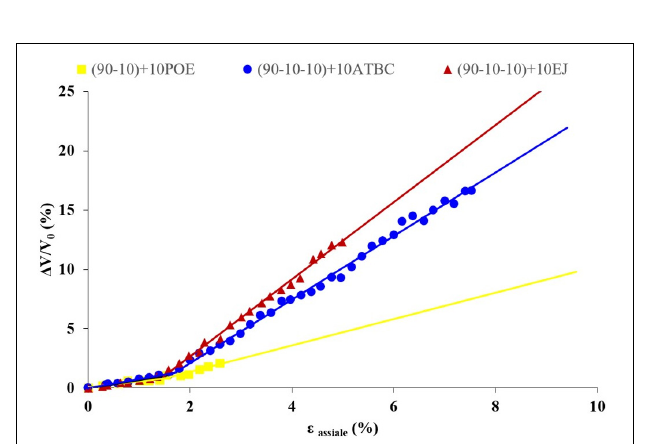
FIGURE 9 | SEM micrographs at the surface of the tensile specimen cryo-fractured along the draw direction for: (A) (90-10)+10POE; (B) (90-10-10)+10ATBC; (C)